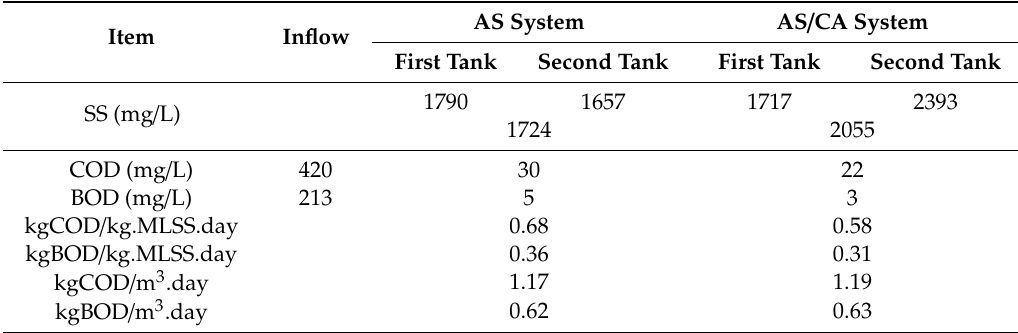
Table 10. Comparison of performance of treatment of synthetic domestic sewage using AS system and AS/CA system .